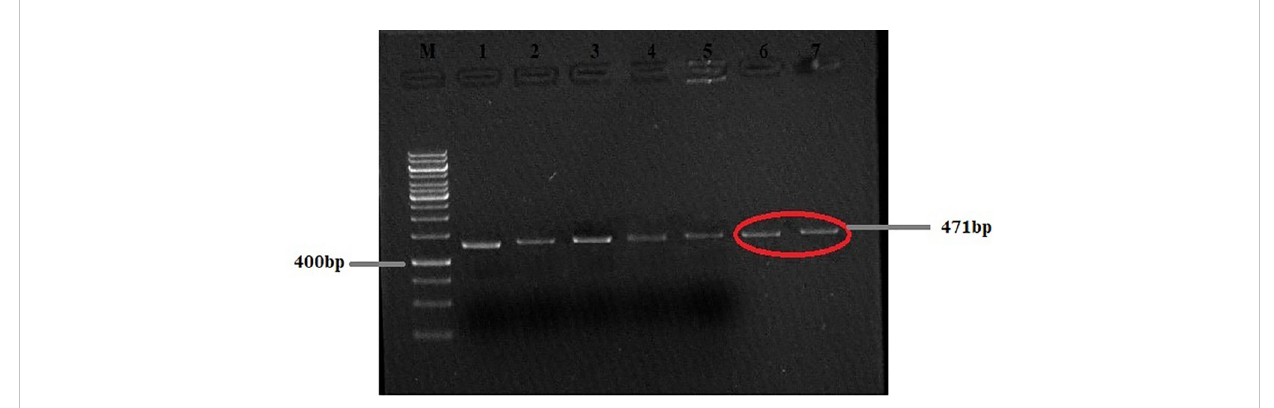
FIGURE 2 Agarose gel (2%) of Echinococcus granulosus Nad1 gene PCR-ampli fi ed product. M, 50-bp molecular ladder; HC, human cyst (the gels are